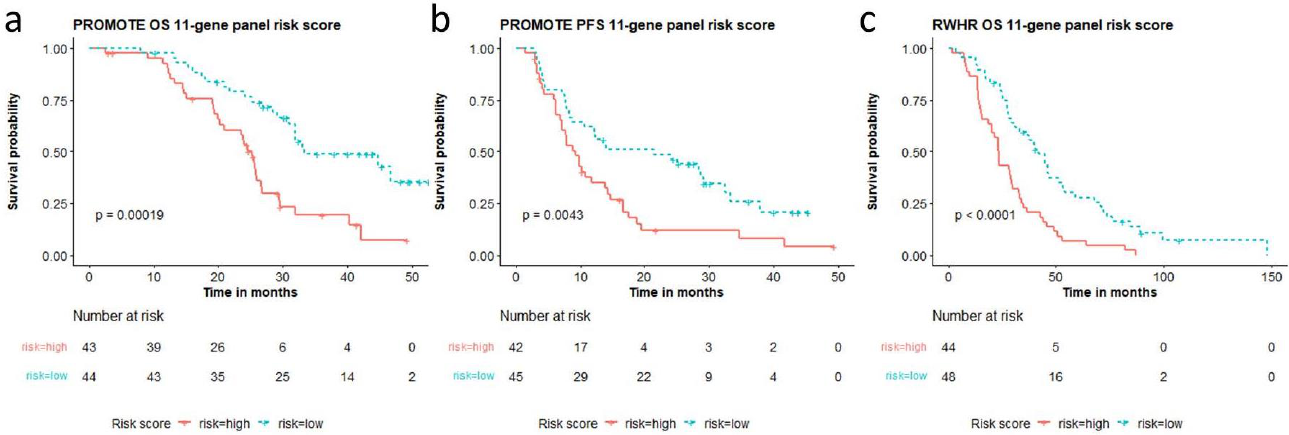
Figure 3. 11-gene panel based high and low risk score association with overall survival (OS) and progression free survival (PFS). Risk scores calculated from the 11-gene panel ( AR , COL22A1 , MYC , NCOR1 , NKX3.1 , NOTCH1 , PIK3CA , PIK3CB , TMPRSS2 , TP53 , ZBTB16 ) are significantly associated with ( a ) overall survival and ( b ) AA/P treatment resistance in the PROMOTE cohort, and ( c ) overall survival in the RWHR cohort.